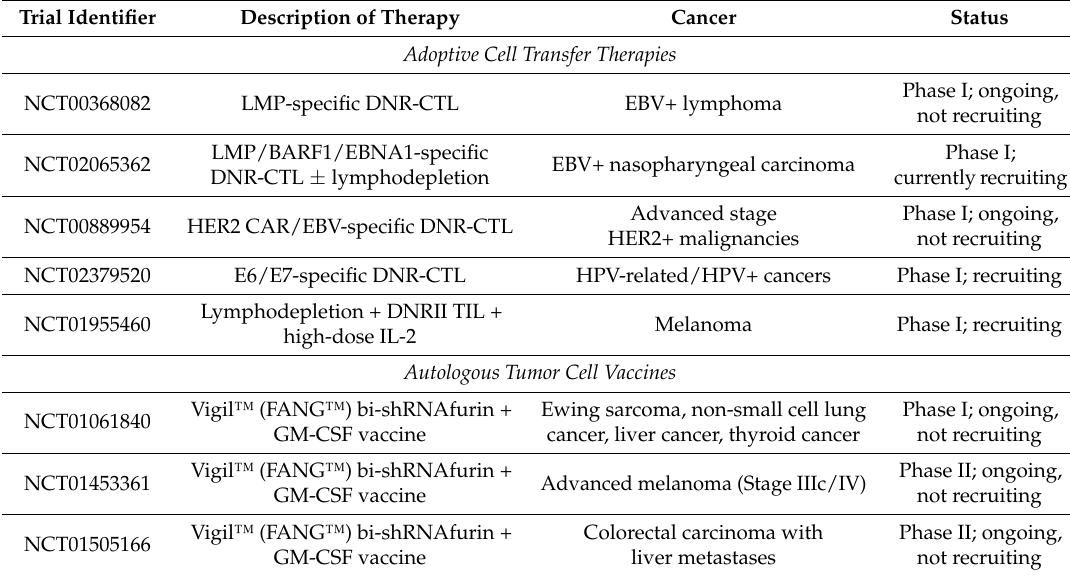
Table 1. Ongoing cancer clinical trials targeting TGF β 1 to improve immunotherapy. Clinical trial information obtained from